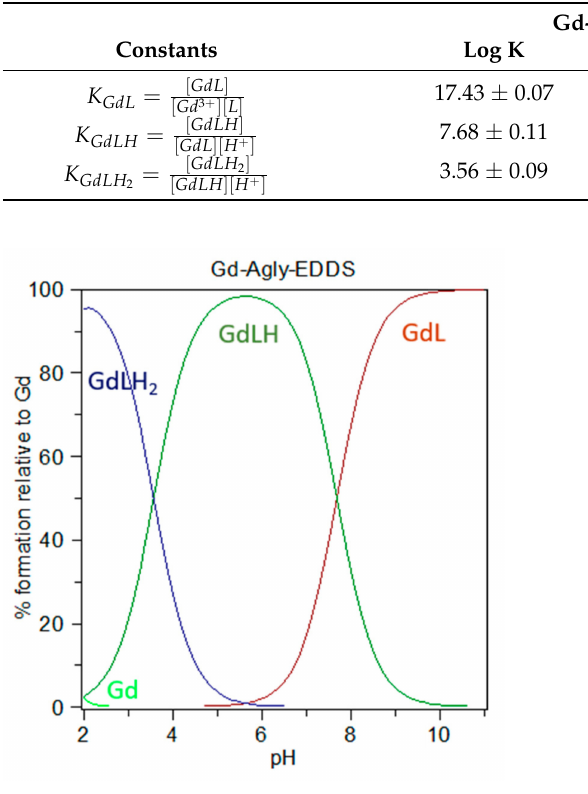
Figure 6. Species distribution diagrams for 1:1 Gd-Agly-EDDS complex (charges of the species are